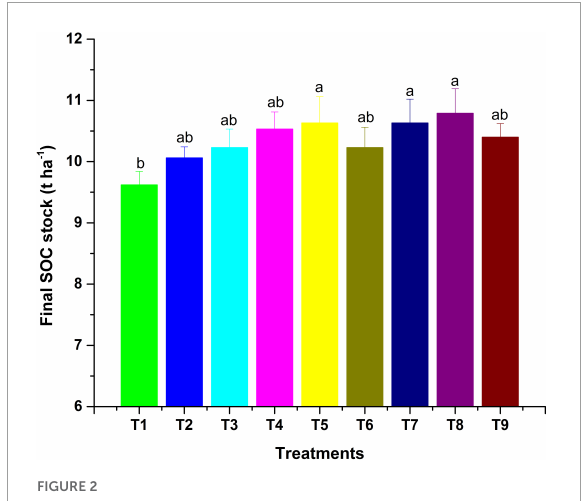
FIGURE2 Final SOC stock as influenced by MI-mediated nutrient management. Different letters in alphabetical orders in figure are generally assigned to indicate the significantly different values at p < 0.05 according to Duncan’s multiple-range test for separation of means.